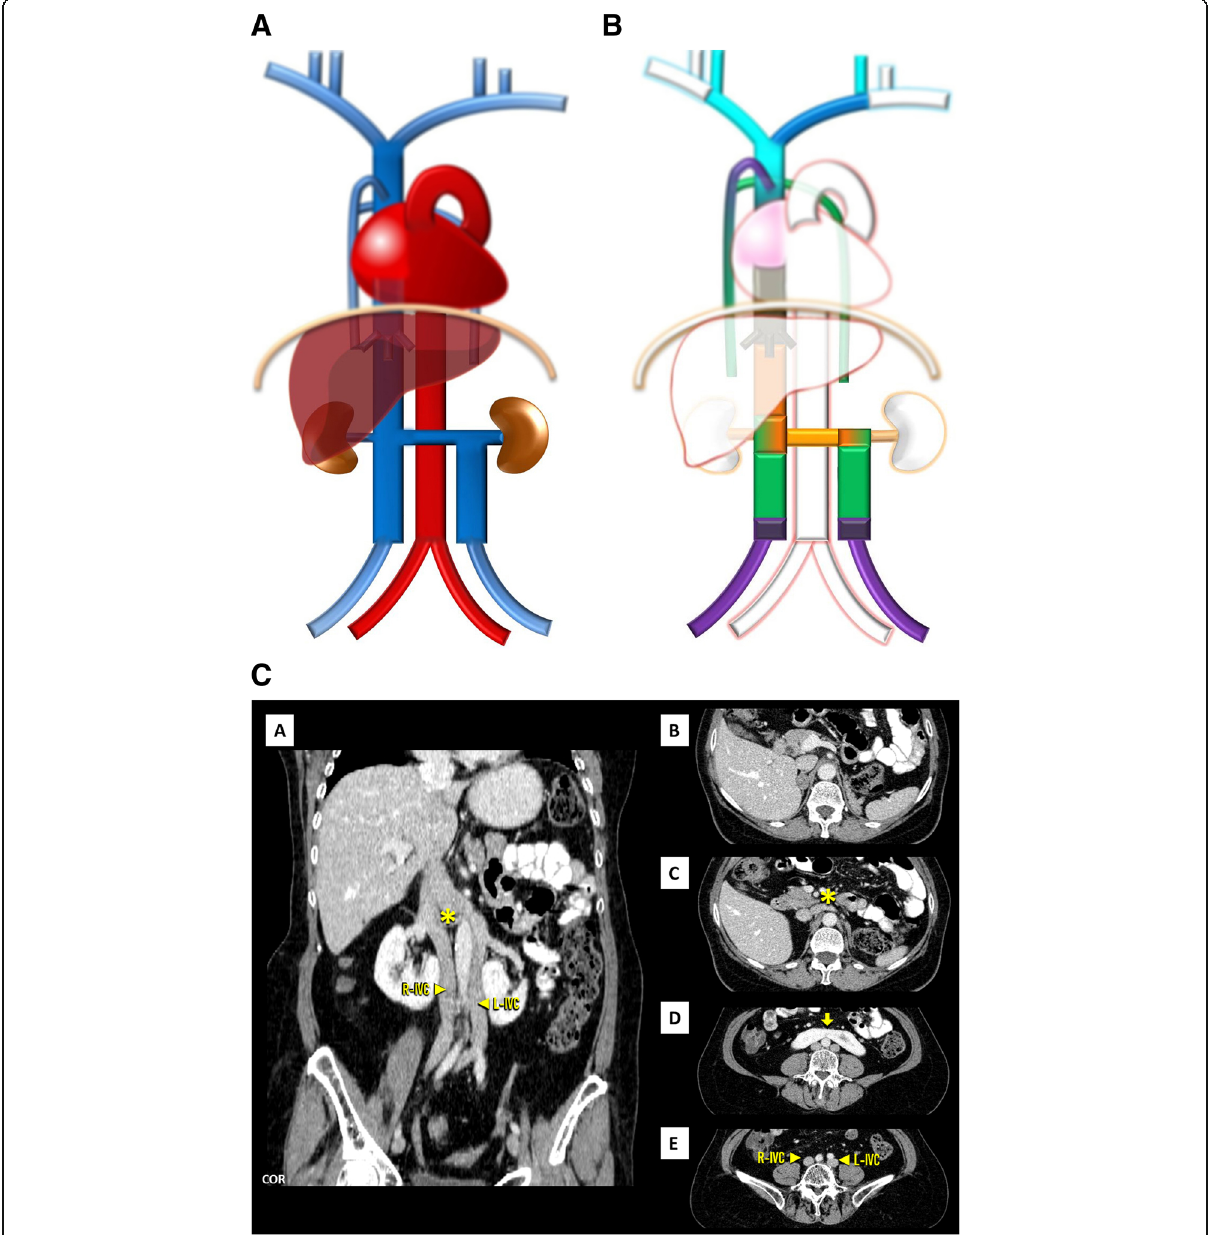
Fig. 6 a Double IVC schematic. With the left component draining to the left renal vein, which joins the right IVC as normal. b Double IVC embryology schematic. Double IVC resulting from the persistence of both supra cardinal veins, uniting in a single trunk on the right through the sub-supra and inter- sub cardinal anastomosis, forming the left renal vein. c Double IVC imaging. Contrast-enhanced CT showing duplicated IVC, with a normal right- sided IVC (R-IVC) and a left-sided IVC (L-IVC) which ends at the left renal vein (asterisk) [C], note also horseshoe kidney (arrow)